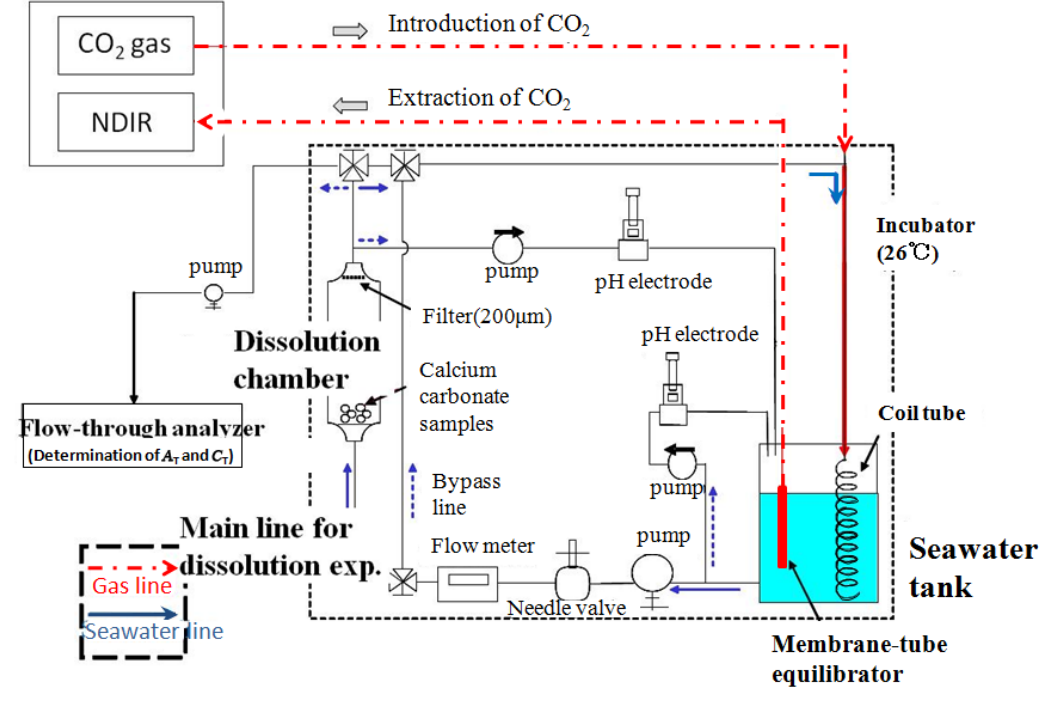
Fig. 1. Experimental